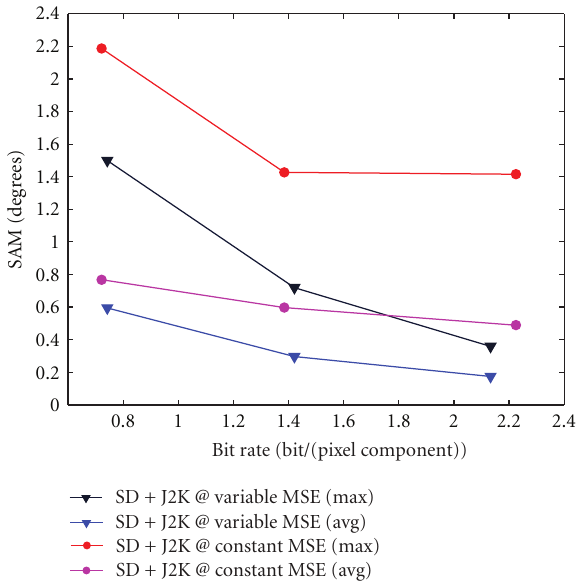
Figure 8: Average angular error between original reflectance spec- tra and those obtained from compressed radiance data plotted ver- sus bit rate for fixed and variable MSE allocation. Table 1: SAM threshold values for library spectra of clays. = ? / = SAM ≤ 4 ◦ 4 ◦ < SAM ≤ 6 ◦ 6 ◦ <